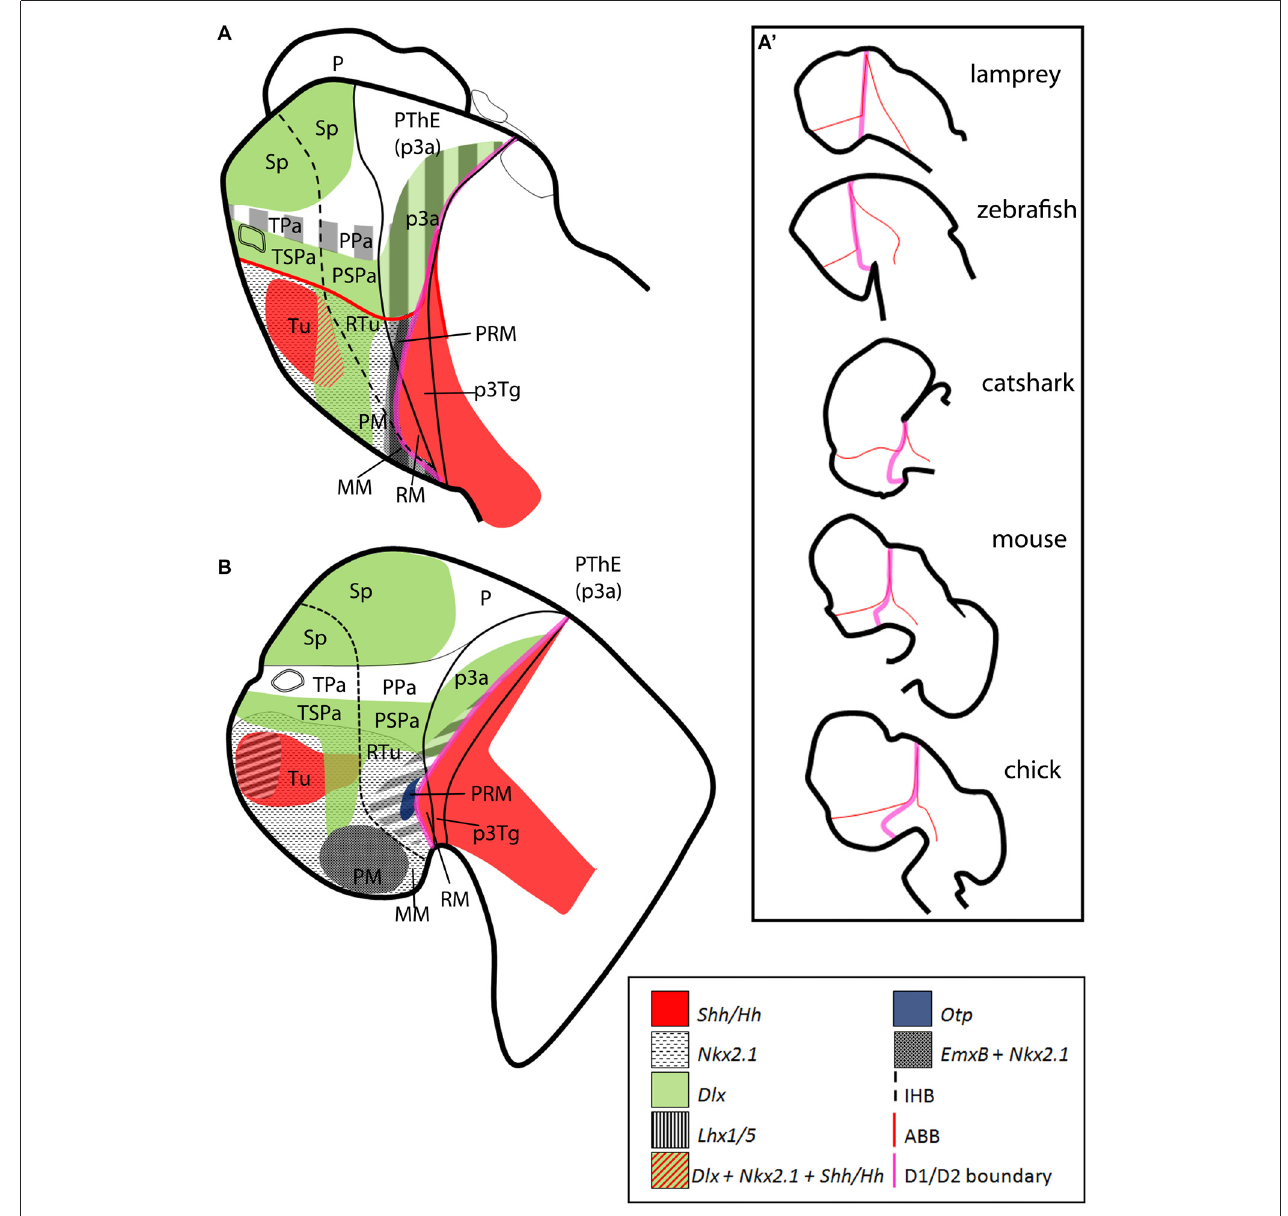
FIGURE 8 | Sagittal schematic representations of the expression patterns of some orthologs here considered in (A) lamprey (adapted from Martínez-de-la-Torre et al., 2011) and (B) zebrafish (adapted from Hauptmann and Gerster, 2000). Schemes represent parasagittal sections at mid development. (A (cid:48) ) Conserved expression patterns suggest an alternative segmental border (pink line), which become deformed through evolution (adapted from Moreno and González, 2011). Data based on the following literature: (A) Murakami et al. (2001); Myojin et al. (2001); Ogasawara et al. (2001); Uchida et al. (2003); Osorio et al. (2005); Osório et al. (2006); Guérin et al. (2009); Tank et al. (2009); Kano et al. (2010); Martínez-de-la-Torre et al. (2011); Sugahara et al. (2011); (B) Barth and Wilson (1995); Hauptmann and Gerster (2000); Mathieu et al. (2002); Kapsimali et al. (2004); Jeong et al. (2006); Filippi et al. (2007, 2012); Ryu et al. (2007); Del Giacco et al. (2008); Osório et al. (2010); Yang et al. (2012); Lauter et al. (2013); Wolf and Ryu (2013); Manoli and Driever (2014). For abbreviations, see